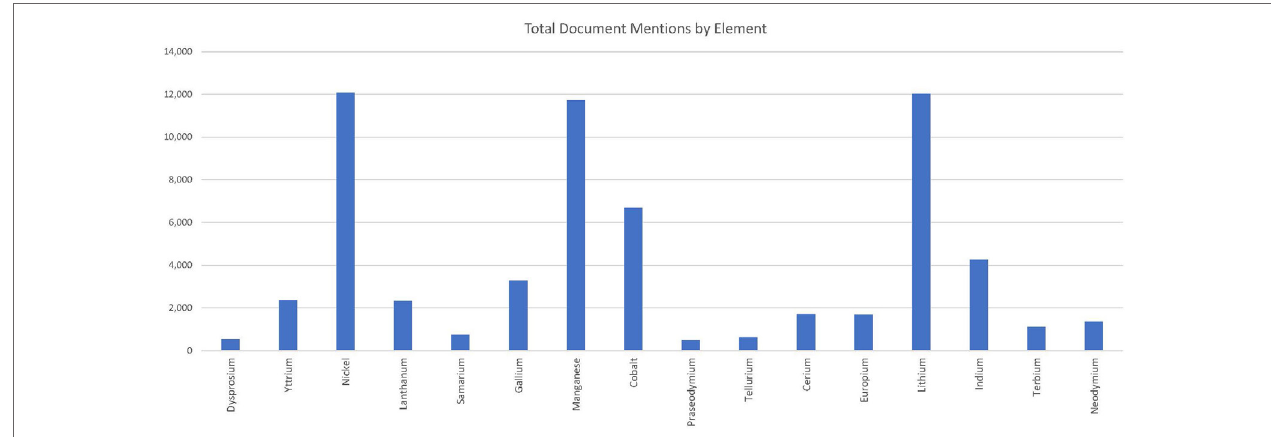
FigUre 6 | The number of documents in the 134 relevant clusters that contained a specific element varied from under 1,000 to over 12,000, as shown